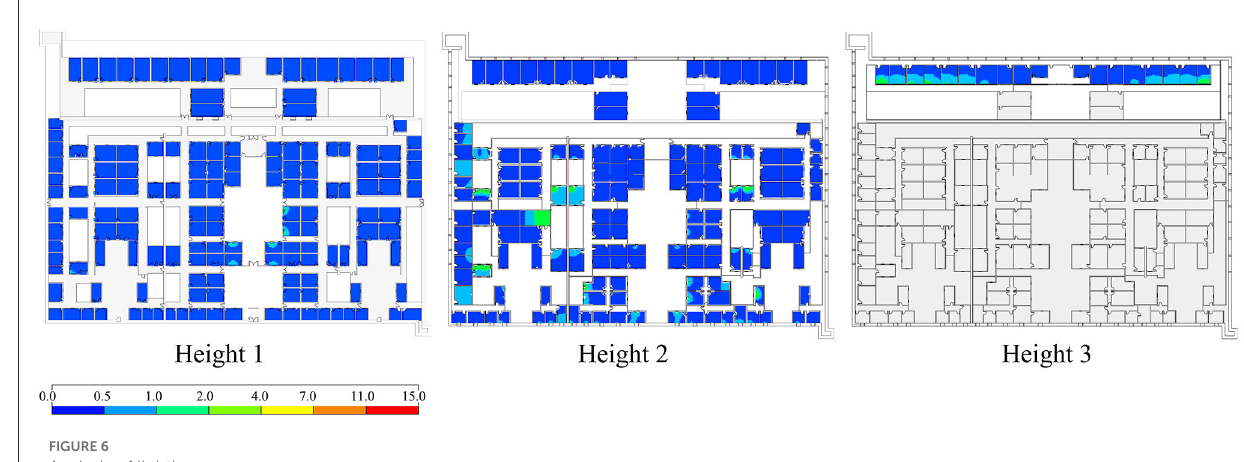
FIGURE6 Analysis of